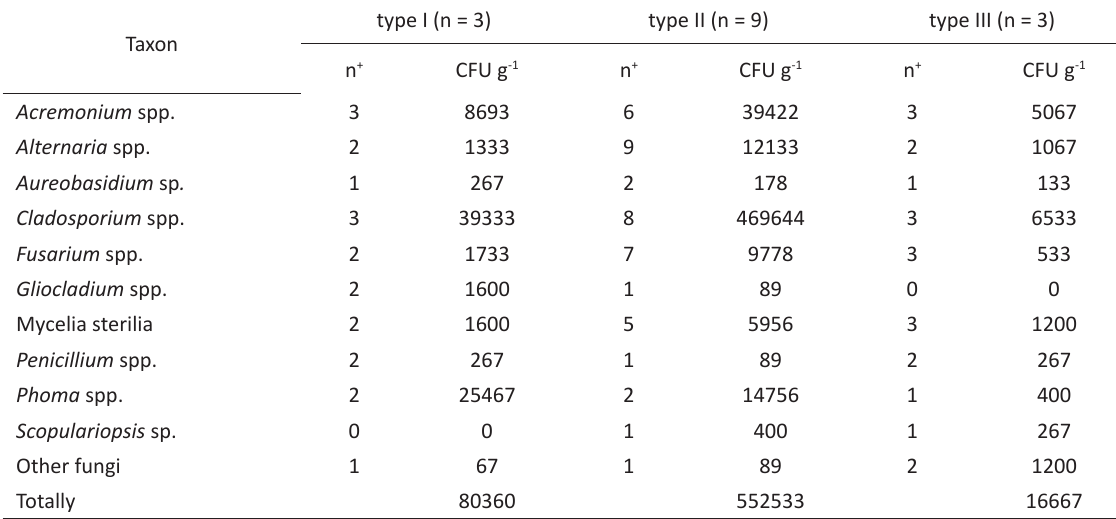
Table 2. The mycobiota of different forage types before the second mowing type I (n = 3) Taxon n + CFU g -1 CFU g -1 Acremonium spp.